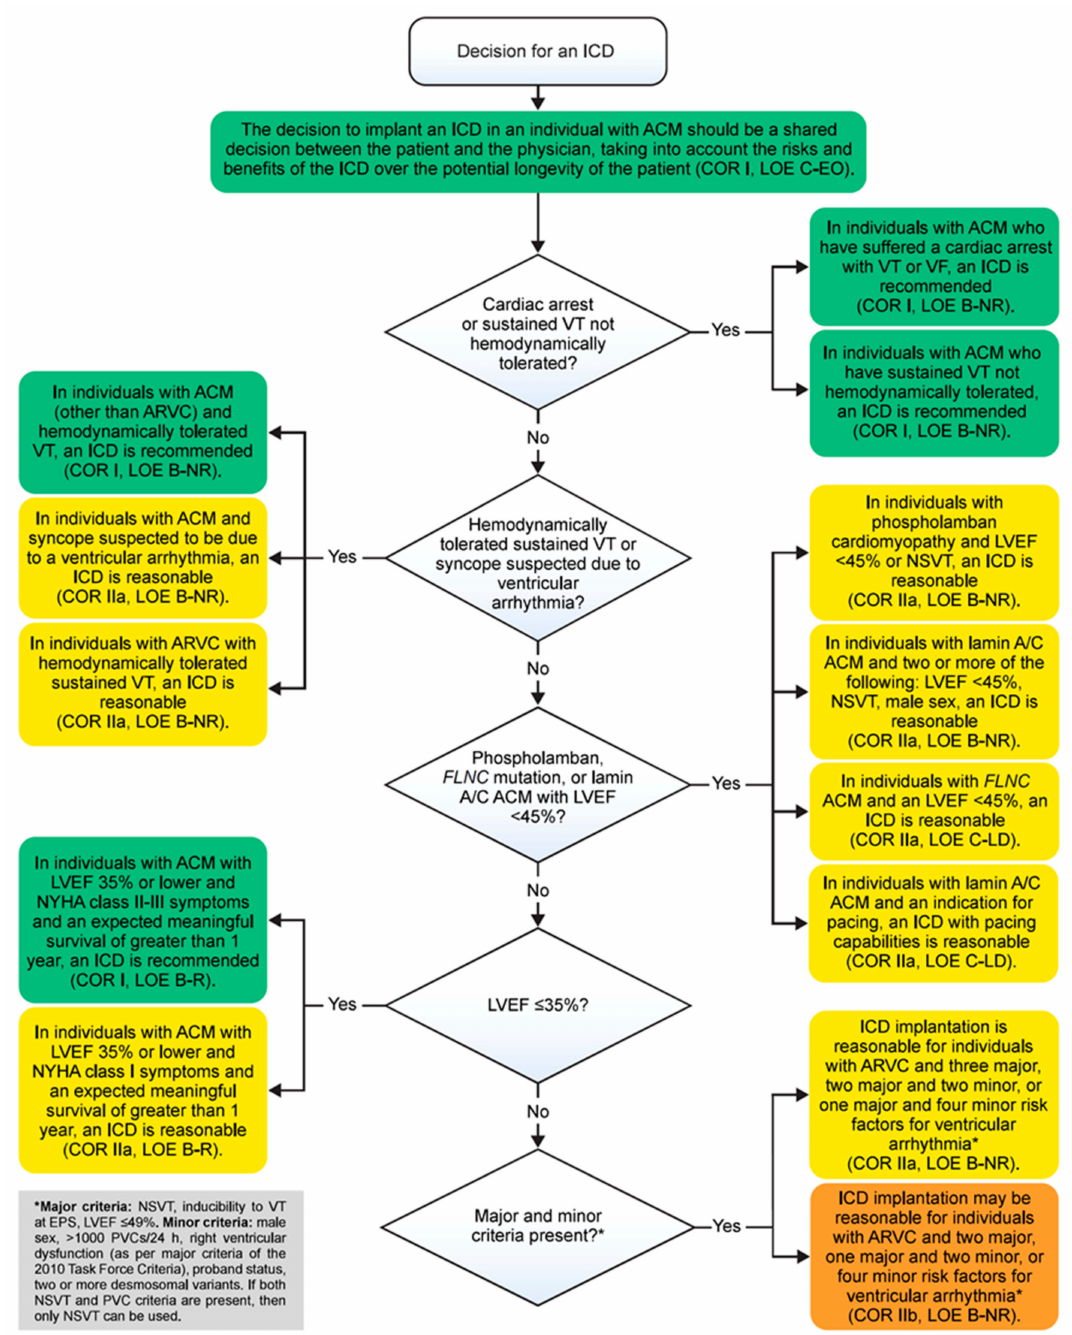
Figure 6. Implantable cardioverter defibrillator (ICD) recommendations. ACM, arrhythmogenic cardiomyopathy; ARVC, arrhythmogenic right-ventricular cardiomyopathy; COR, class of recommendation; EPS, electrophysiology studies; FLNC, filamin-C; LOE, level of evidence; LVEF, left-ventricular ejection fraction; NSVT, non-sustained ventricular tachycardia; NYHA, New York Heart Association; PVC, premature ventricular contraction; VF, ventricular fibrillation; VT, ventricular tachycardia. Colors correspond to COR (green—class I; yellow—class IIa; orange—class IIb). Adopted from Towbin, J.A.; McKenna, W.J.; Abrams, D.J.; Ackerman, M.J.; Calkins, H.; Darrieux, F.C.C.; Daubert, J.P.; de Chillou, C.; DePasquale, E.C.; Desai, M.Y.; et al. 2019 HRS expert consensus statement on evaluation, risk stratification, and management of arrhythmogenic cardiomyopathy. Heart Rhythm 2019, 16,